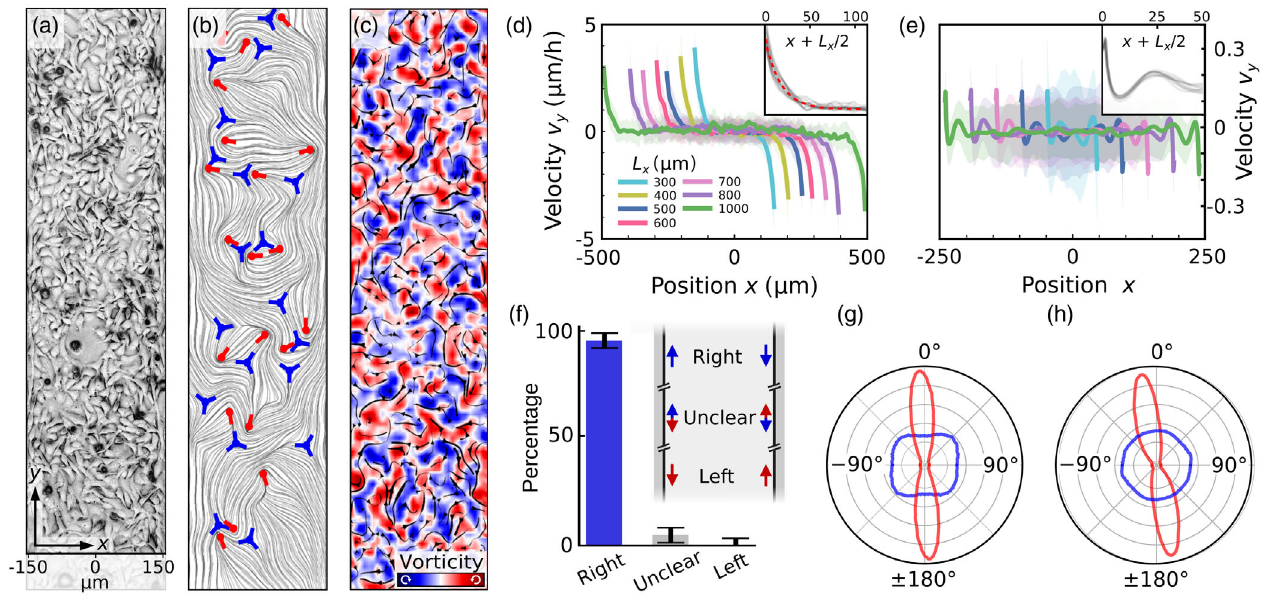
FIG. 1. HT1080 cell monolayer on an adhesive stripe. (a) Phase contrast image in inverted gray scale. (b) The nematic director field extracted from (a) with positive (red) and negative (blue) locations and orientations of half integer defects. (c) Black velocity streamlines are overlaid on the normalized vorticity field (blue, clockwise; red, counterclockwise). (d) Average flow along the channel shows boundary flows with net chirality. Boundary flows have a constant width independent of channel dimensions which can be observed by translating the curves onto each other. This exposes a constant decay length ( 23 μ m) that can be estimated by fitting an exponential (dashed red line, R 2 ¼ 0 . 99 ) (inset). (e) Average flow for a simulated chiral active nematic ( α ¼ − 10 , τ ¼ − 2 . 5 ) also shows boundary flows with net chirality and constant length scale (inset). (f) Chirality of edge flow direction in 360 fields of view is right-handed in 95% of cases and unclear in the remaining 5% of cases (see Appendix for details). (g) Average cell orientation at the edge (red) and center (blue) of the channel showing boundary alignment with a chiral tilt. (h) Average director orientation at the edge (red) and center (blue) for a simulated chiral active nematic, again with boundary alignment with a distinct chiral tilt. Simulation units and parameter values are given in the